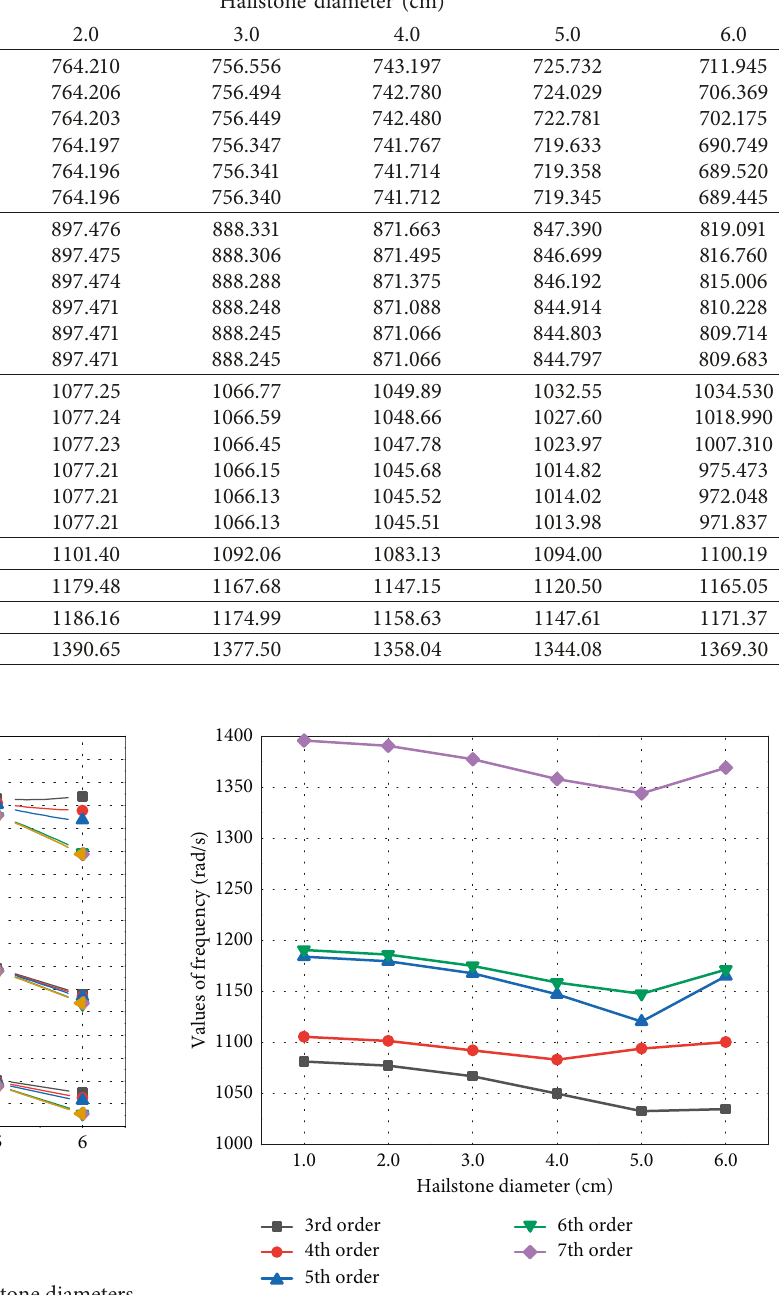
Figure 12: Frequencies (rad/s) under different hailstone diameters at t �